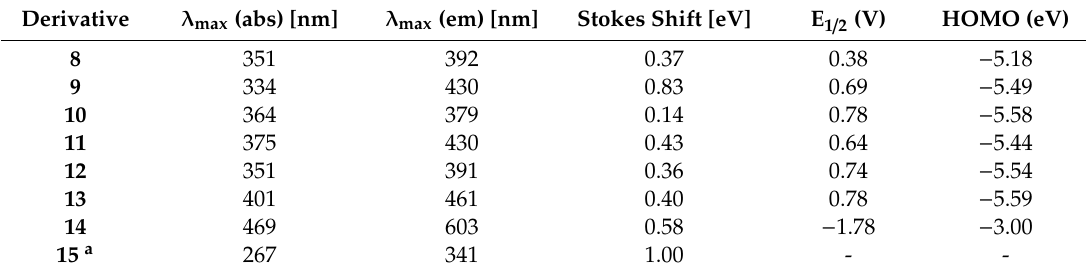
Table 3. Optical and electrochemical properties of compounds 1 , 8 – 15 in CH 2 Cl 2 : linear